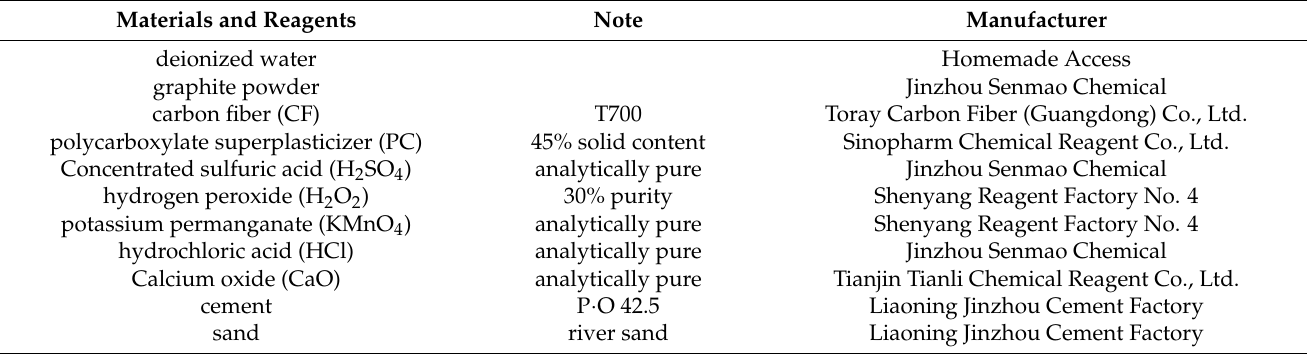
Table 1. Reagents and raw materials used in the experiment.